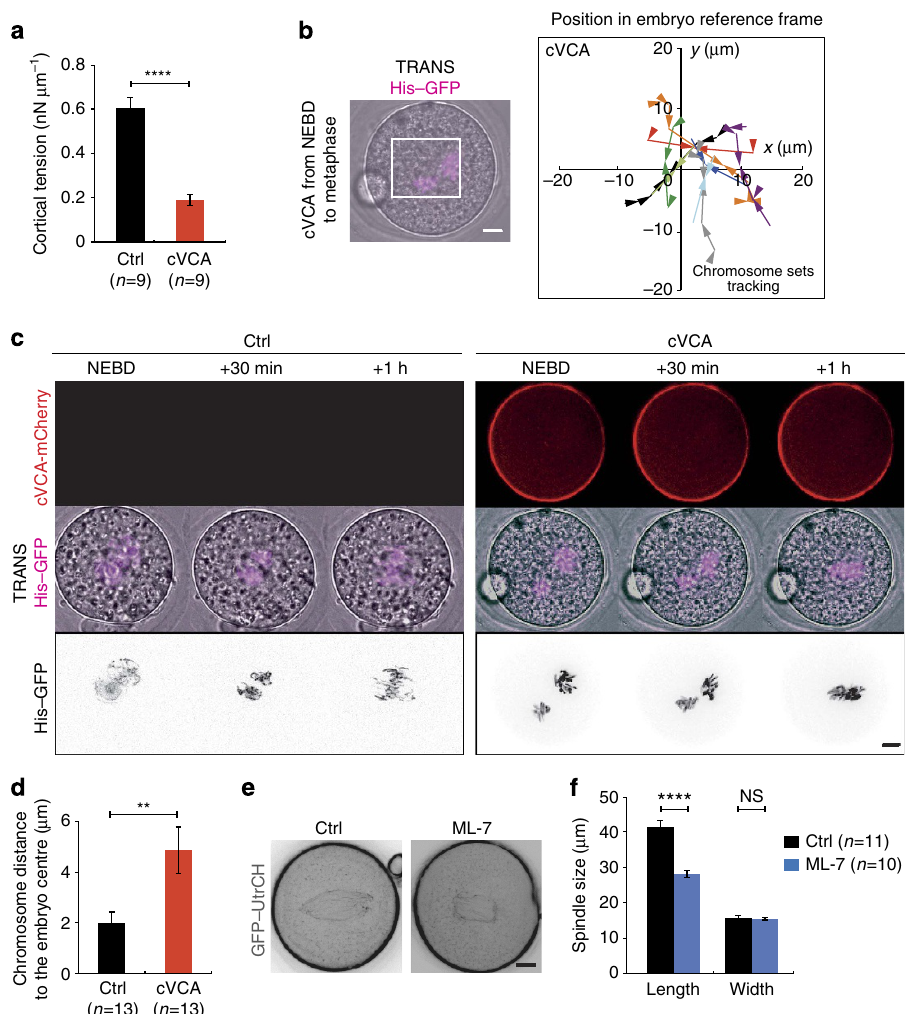
Figure 6 | Decreasing cortical tension impairs the fine centring of the chromosomes. ( a ) Bar graph showing the values of cortical tension of a mitotic embryo expressing cVCA (red bar) or not (black bar). Mean is shown over two independent experiments. s.e.m. is plotted on each bar. Statistical significance of differences is assessed with a t -test ( P value o 0.0001). ( b ) Left panel: Embryo expressing His–RFP (purple, Z-projection over 20 m m) together with cVCA during the migration of the two sets of chromosomes. Scale bar, 10 m m. Right panel: graph showing the position of the centroid of the two sets of chromosomes in the referential of the embryo (0 being the centre) from NEBD to metaphase for representative embryos expressing cVCA. The scale is represented by the white box on the left panel. Each colour represents an embryo. The arrows point to the position where the two sets of chromosomes merge. One time point is shown every 30min. ( c ) Embryos expressing His–RFP alone (left panels) or together with cVCA (right panels). Upper panel: cVCA (red), one Z-plane is shown; middle and lower panels: His–RFP, purple or black, Z-projection over 20 m m. One frame is shown every 30min. Scale bar, 10 m m. ( d ) Bar graph showing the position of the centroid of the merged chromosomes for controls (black bar) and embryos expressing cVCA (red bar). Mean is shown of 13 controls and 13 embryos expressing cVCA. s.e.m. is plotted on each bar. Statistical significance of differences